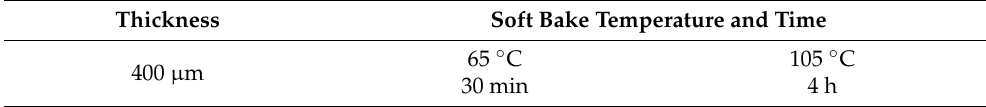
Figure 5. A thin resist layer on the bottom of the SU ‐ 8 resist pattern undeveloped in the developer solution, because it cross ‐ linked in the soft bake at temperature exceeding 130 °C. Table 1. Soft bake temperature and